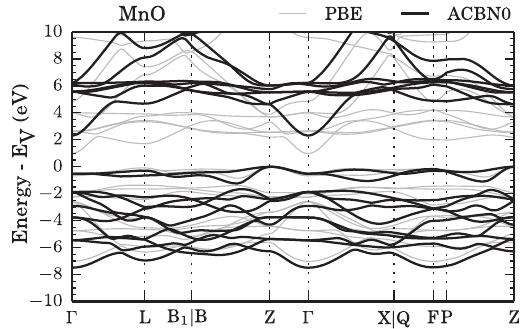
FIG. 2. Band structure (spin up) of manganese oxide. All energies are relative to the valence-band maximum E values of U ¼ 4 . 67 eV for the Mn- 3 d states and 2.68 eV for the O- 2 p states are used in the ACBN0